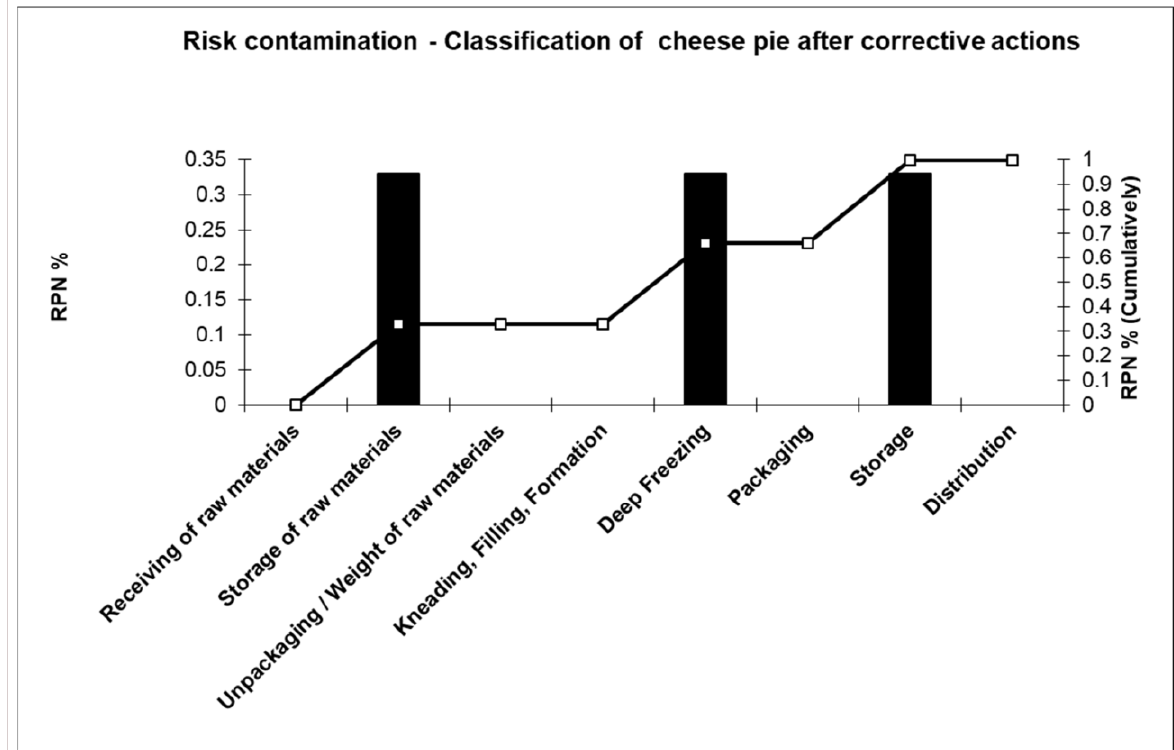
Figure 6. Pareto diagram of cheese pie processing after corrective